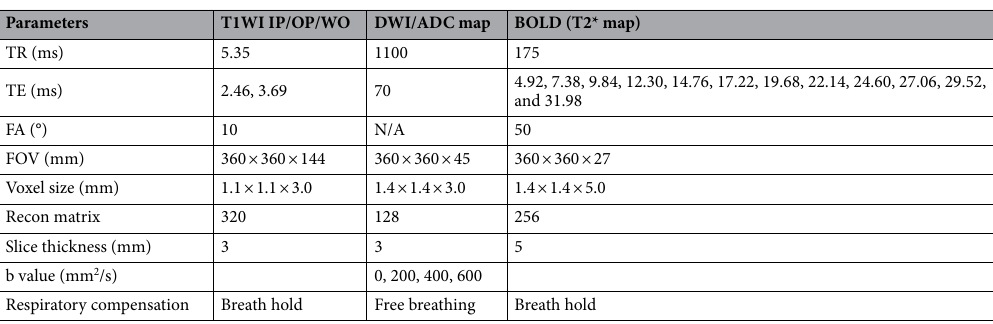
Table 11. Representative MRI scanning sequences and parameters. ADC apparent diffusion coefficient, BOLD blood oxygenation level-dependent imaging, DWI diffusion-weighted imaging, FA flip angle, FOV field of view, IP in-phase, OP opposed-phase, T1WI T1-weighted imaging, TE echo time, TR repetition time, WO water-only.